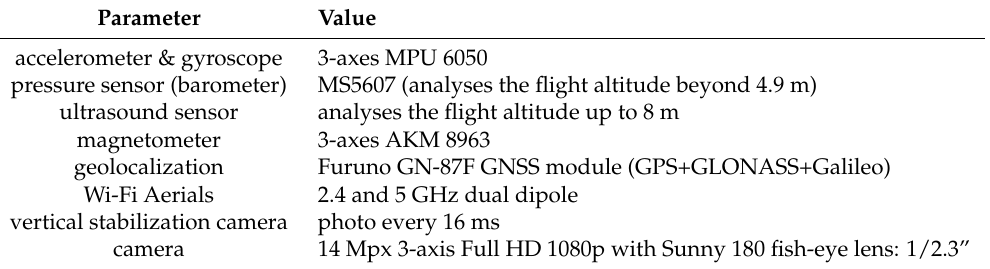
Table 3. General characteristic of Bebop 2